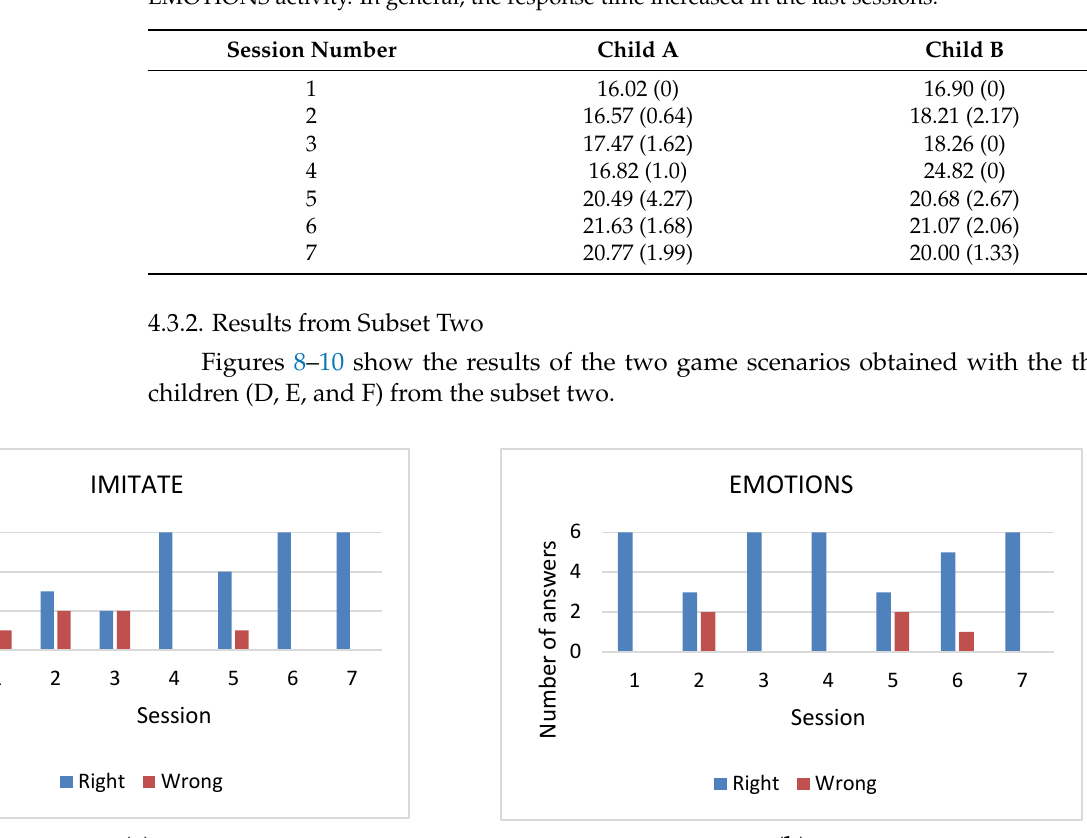
Table 8. Subset one: Children’s mean response time in seconds for successful answers (SD) in the EMOTIONS activity. In general, the response time increased in the last sessions.